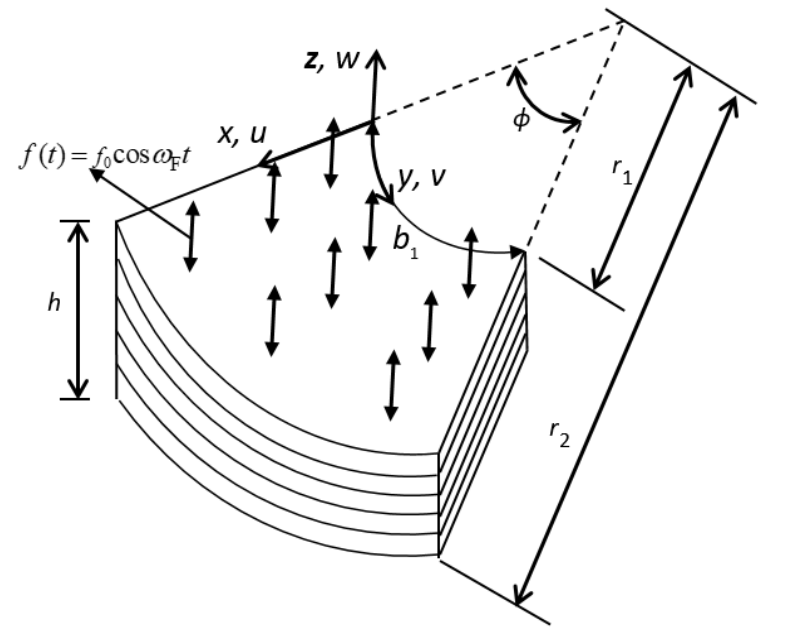
Figure 1. Laminated composite annular sector plate.